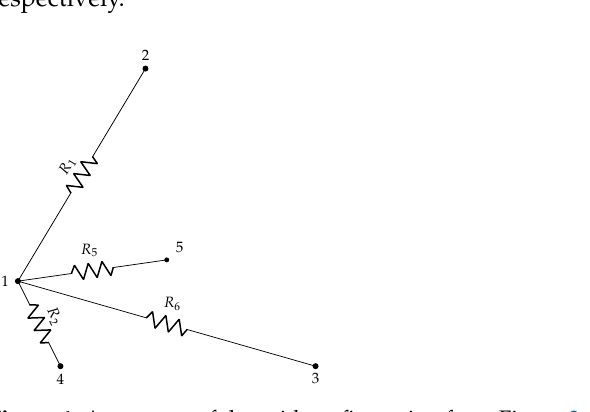
Figure 4. A segment of the grid configuration from Figure 3.